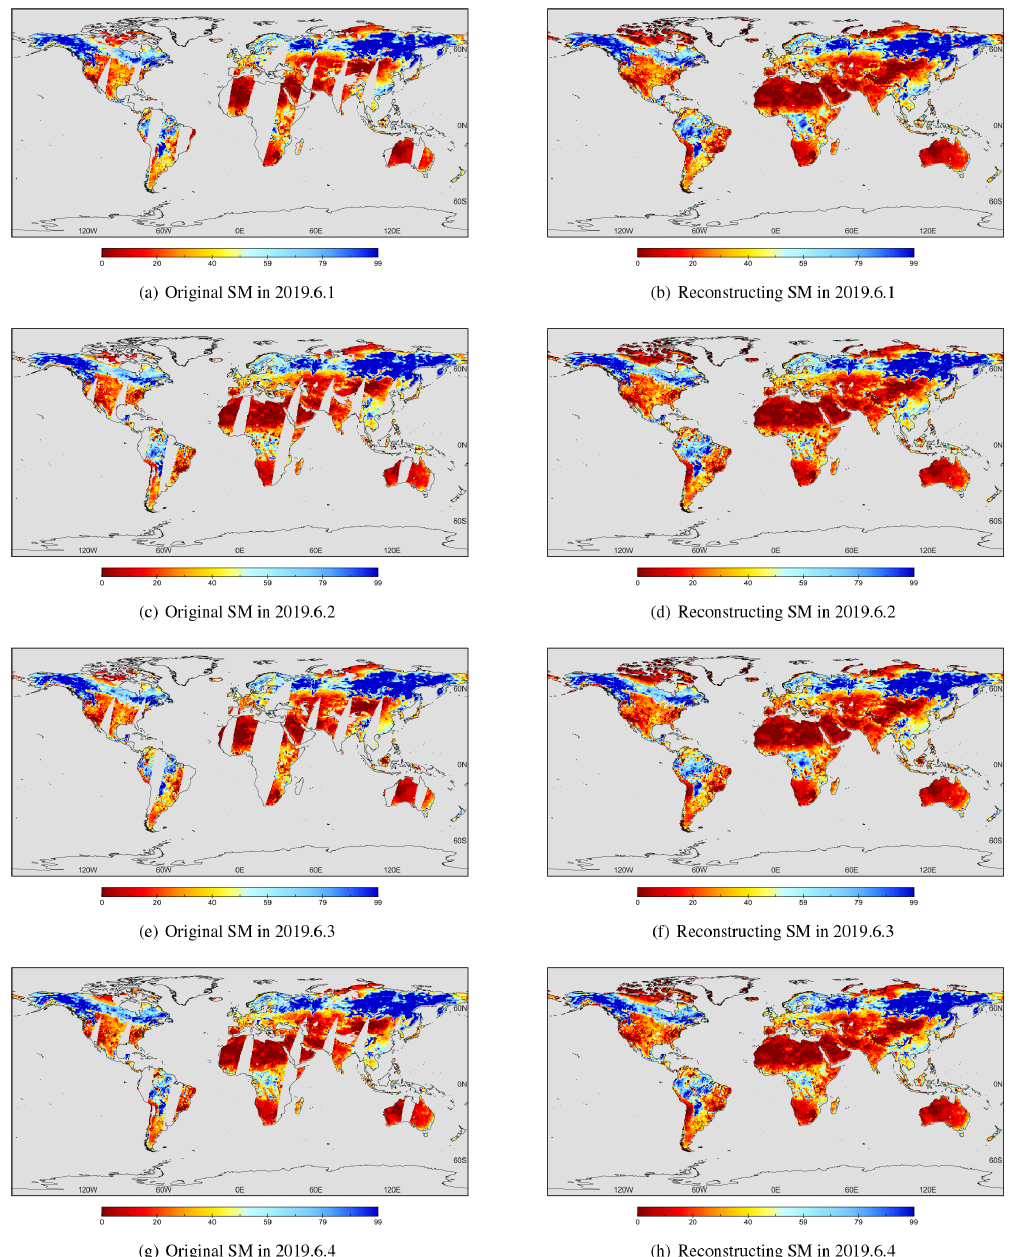
Figure 5. Original and reconstructed global daily SM results between 1 and 4 June